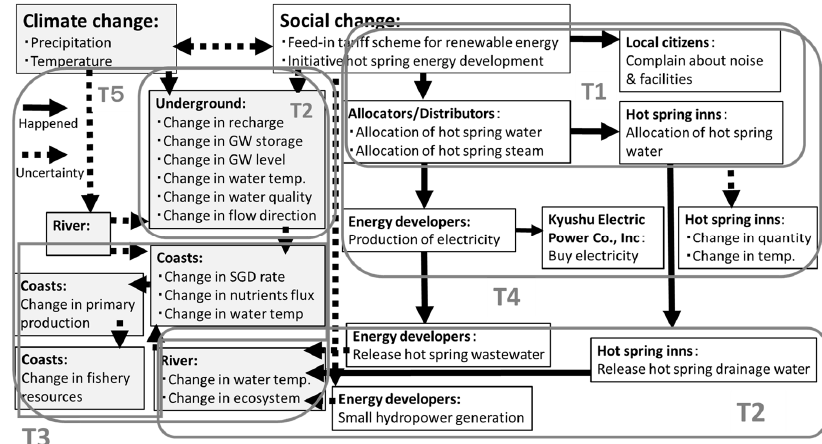
Figure 3. Natural and social events and their linkages in Beppu, Japan; figure modified from the literature [30]. GW: groundwater; SGD: submarine